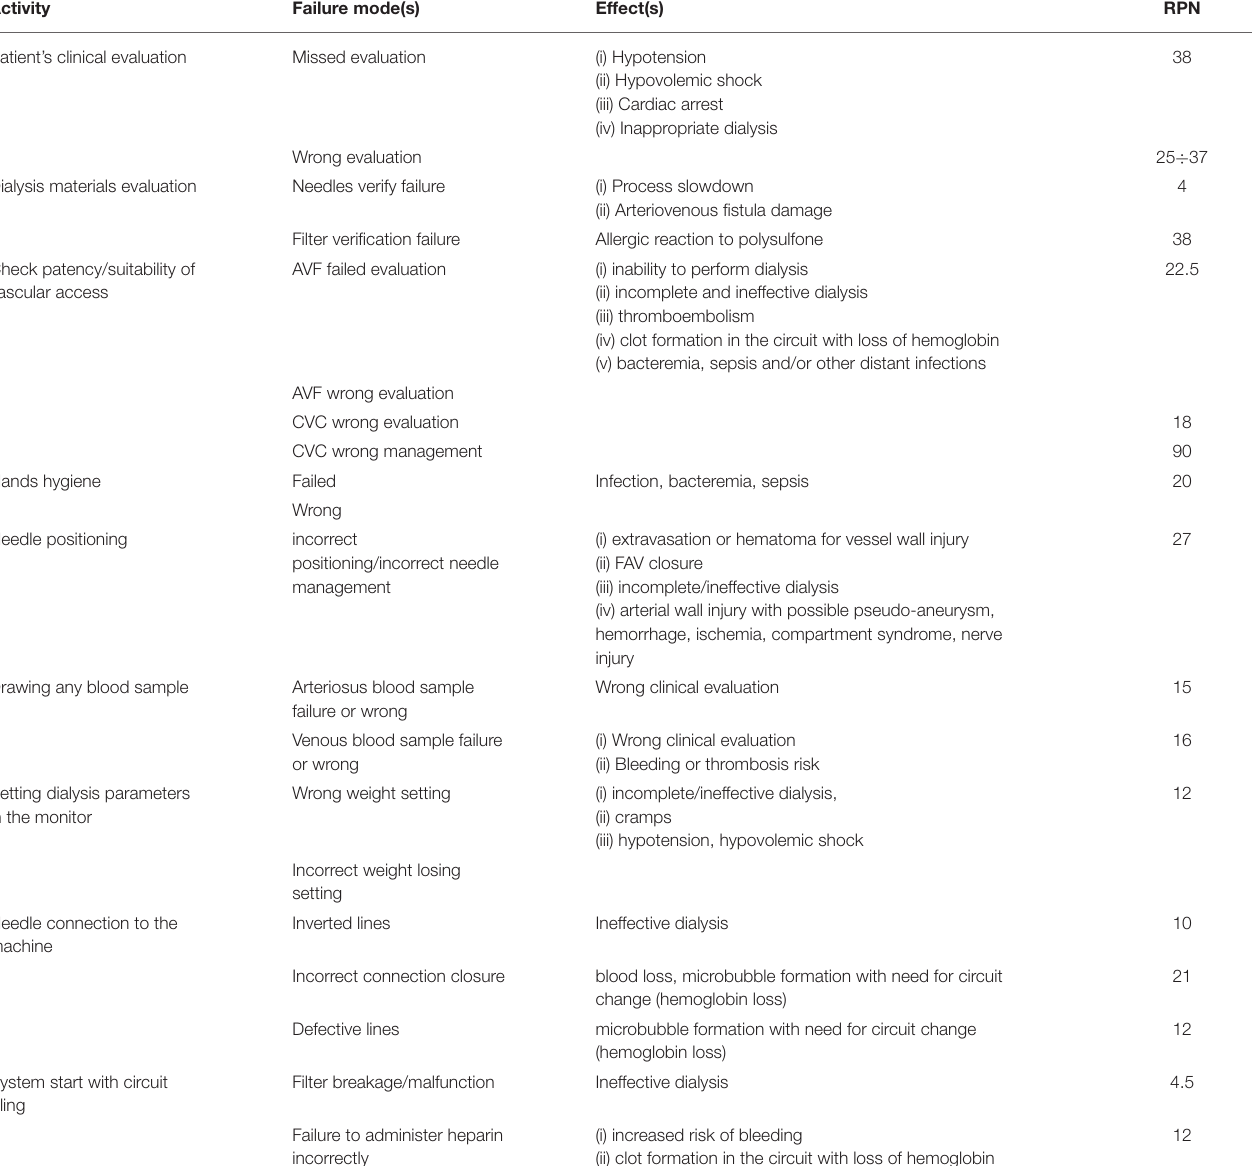
TABLE 3 | Failure modes and relative RPN in phase 2 of HD